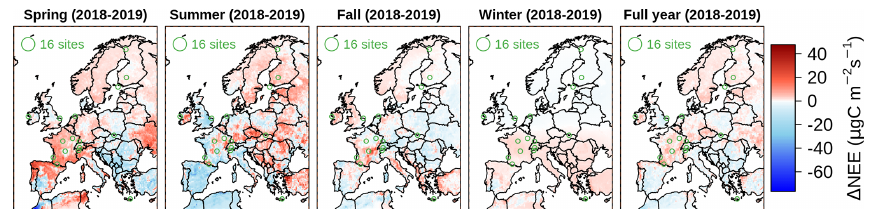
Figure 11. Differences in NEE estimates for 2018–2019 in seasonal and annual mean calculated from the S2 inversion set-up.